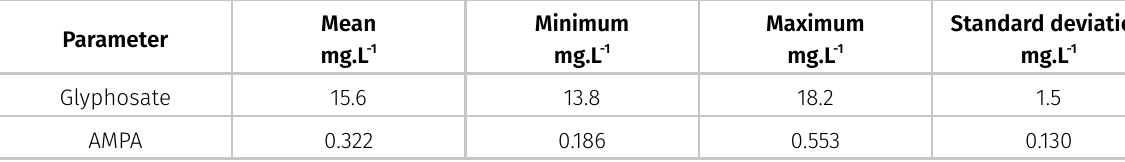
Table II. Glyphosate environmental concentration and AMPA measured in the microcosms.